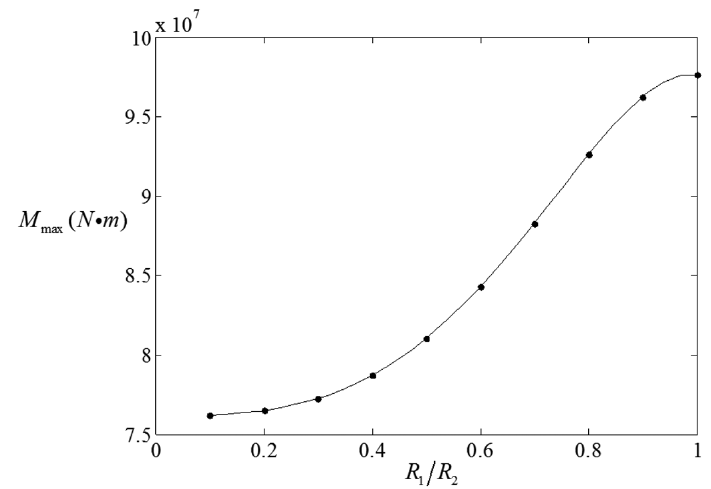
Fig. 16. Maximum amplitude in the time history of the resultant hydrodynamic moment with the center of the bottom of liquid under the Kobe seismic excitation versus R 1 / R 2 for h 1 / R 2 = 0.4. loads. The rigid baf fl e with different radius ratios R 1 / R 2 and different position ratios h 1 / R 2 in a liquid- fi